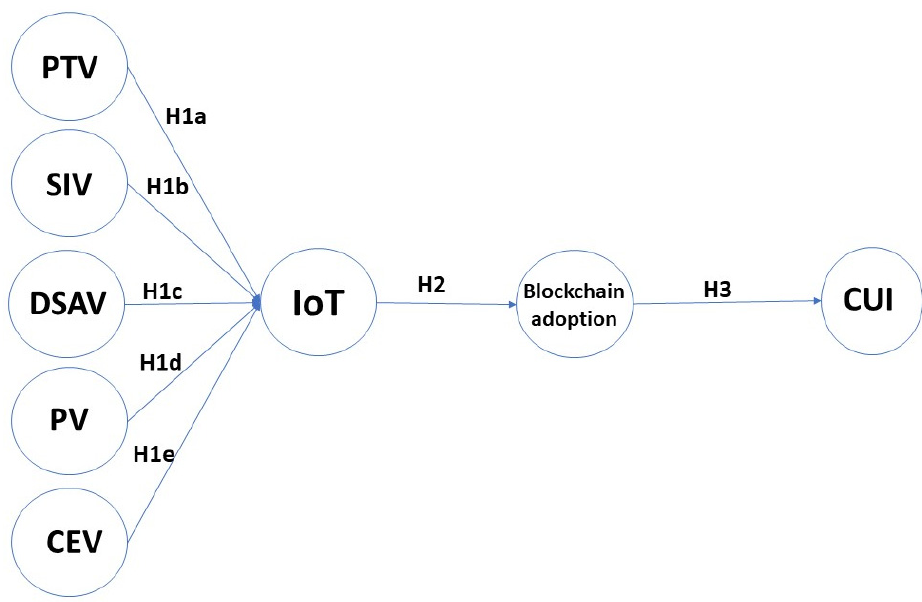
Figure 1. Conceptual Framework.